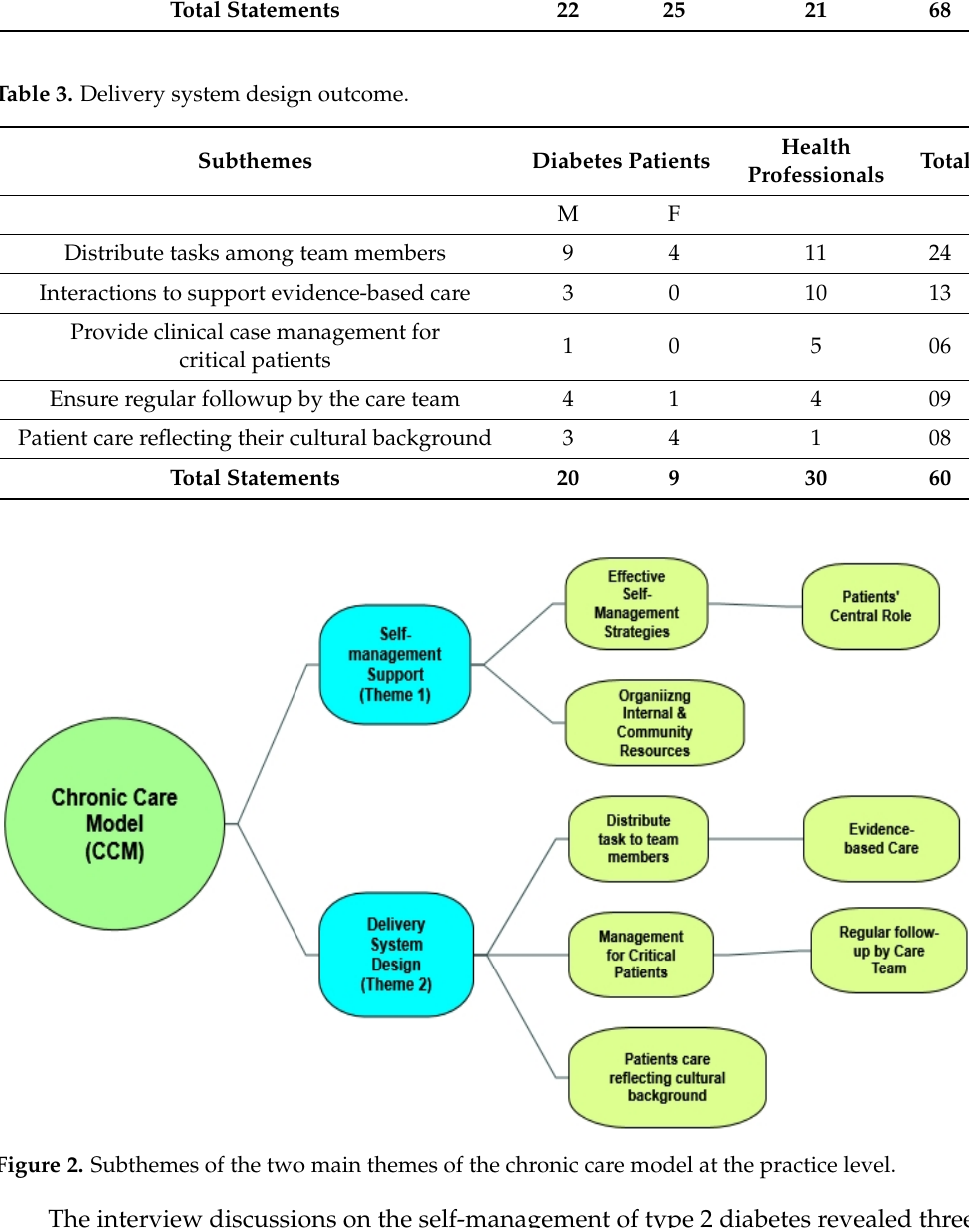
(Table 2). Table 2. Self-management of Type 2 diabetes outcome.